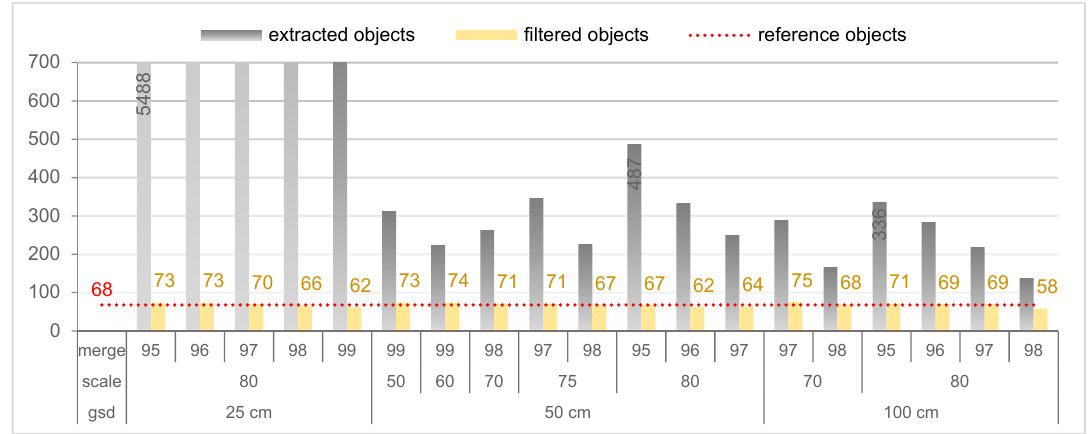
Figure 6. Comparison in the number of extracted and filtered objects using different scale and merge parameter values, to the number of objects identified in the reference data set.